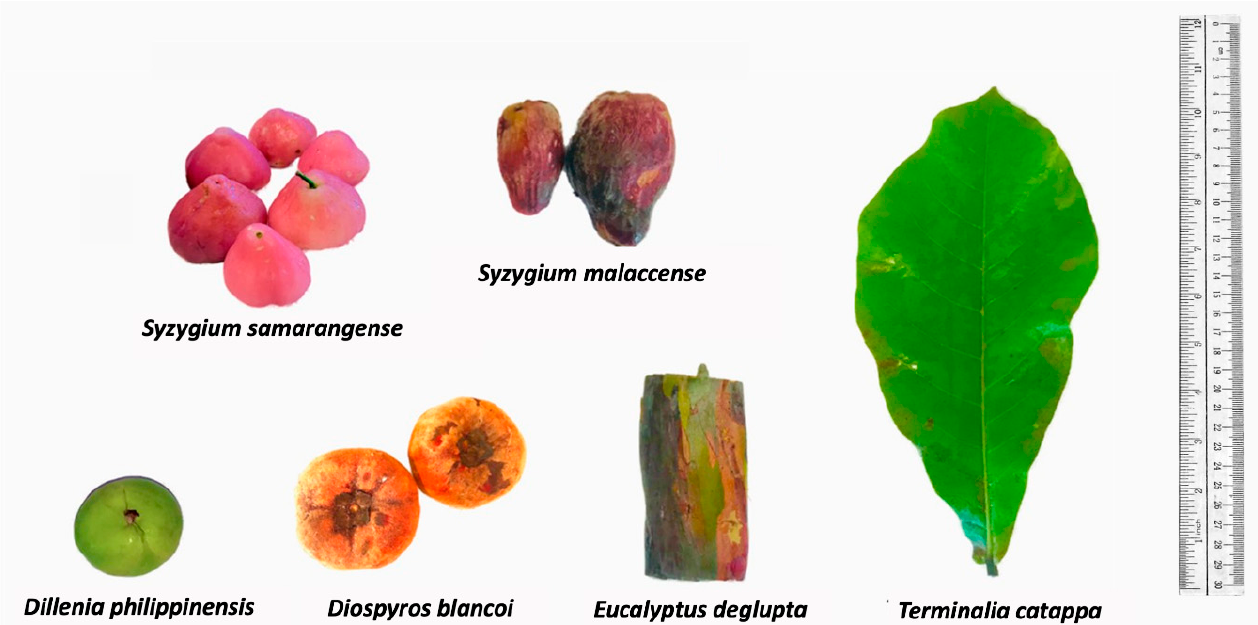
Figure 1. Plant sources of extracted natural dyes. Colorants were extracted from the fruit peel of S. samarangense , S. malaccense , D. philippinensis , and D. discolor , as well as the outer bark of E. deglupta . Resulting chemical profiles were compared with the hydrophilic dye from leaf decoction of T. catappa.